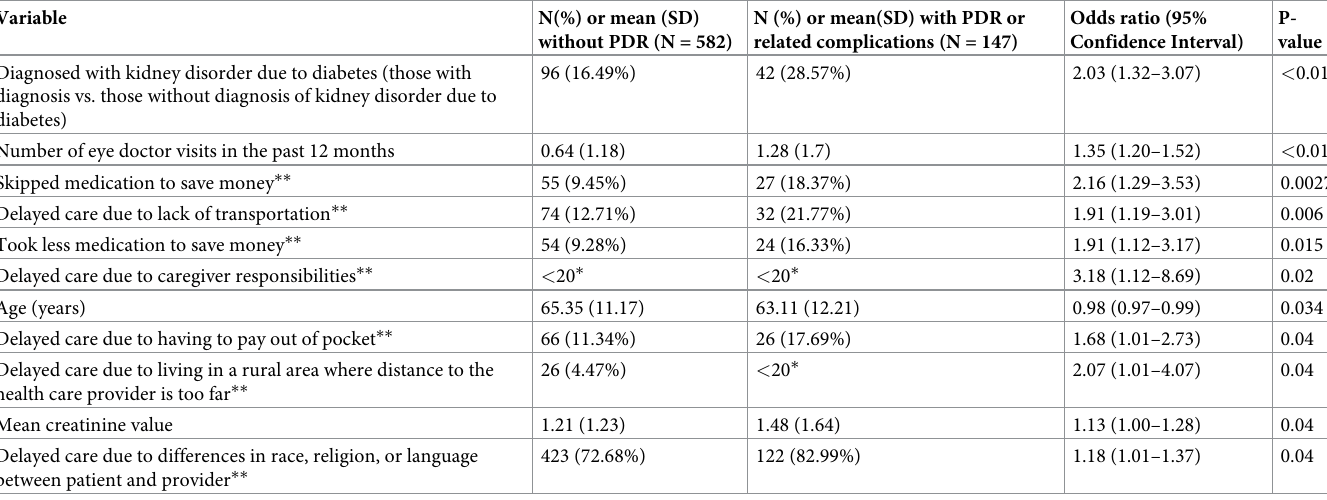
Table 3. Bivariate crude odds ratios for variables associated with increased odds of developing proliferative diabetic retinopathy (PDR) or related complications. Variable